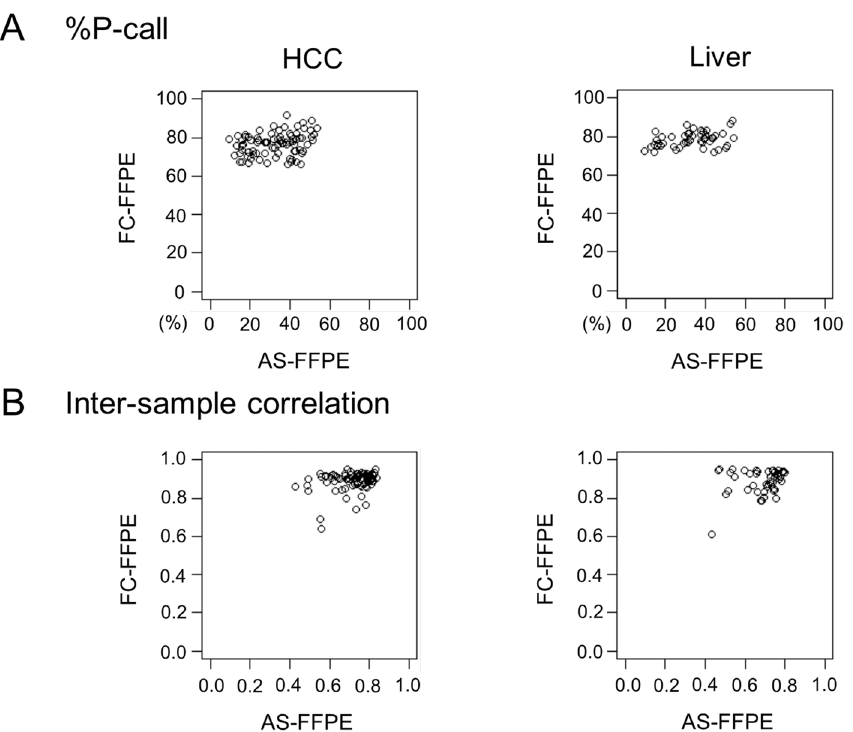
Figure 4. Comparison of (A) %P-call and (B) inter-sample correlation between AS-FFPE and FC-FFPE profiles. AS: archived section, FFPE: formalin-fixed paraffin-embedded, HCC: hepatocellular carcinoma, FC: freshly cut, %P-call: % present call.